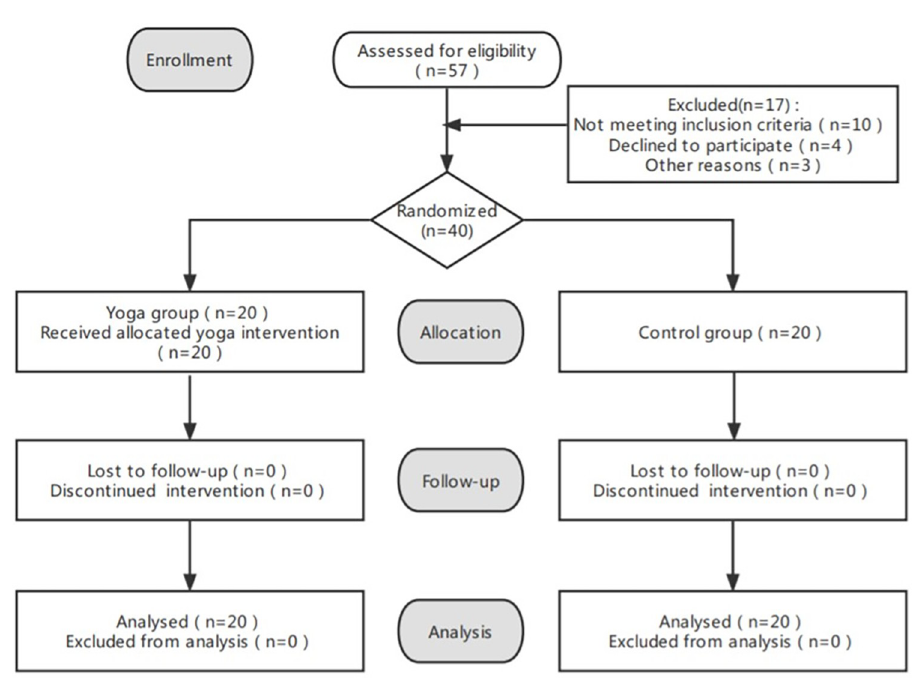
Fig 1. Recruitment flow chart.